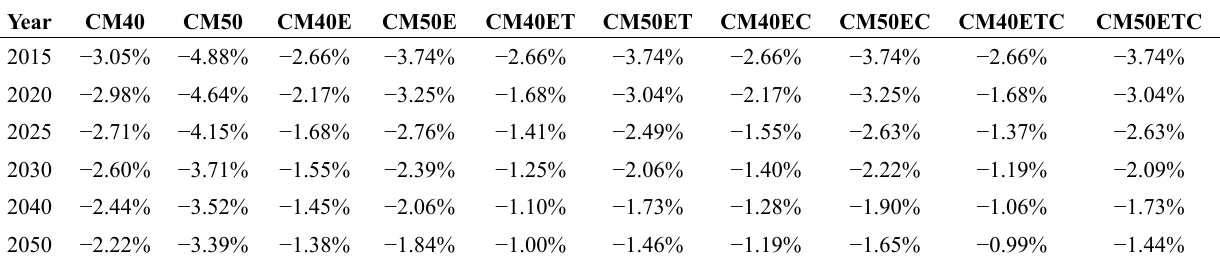
Table A7. Change of gas supply in 2050.